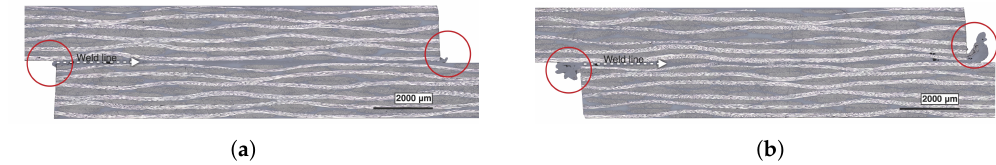
Figure 11. Representative cross-sectional micrographs of continuous ultrasonic welds for ( a ) higher speed case (65 mm/s), and ( b ) lower amplitude case (70 µ m). Red circles indicate squeeze-out